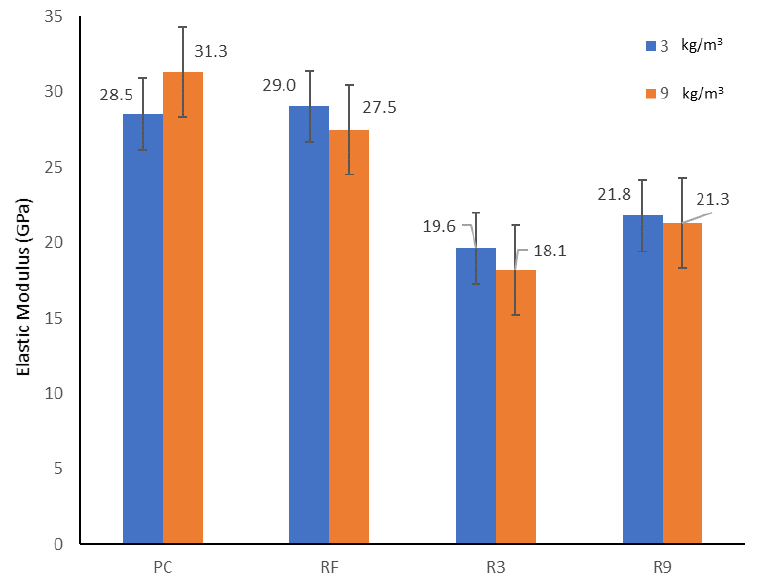
Figure 7. The compressive strength result of tested concrete.